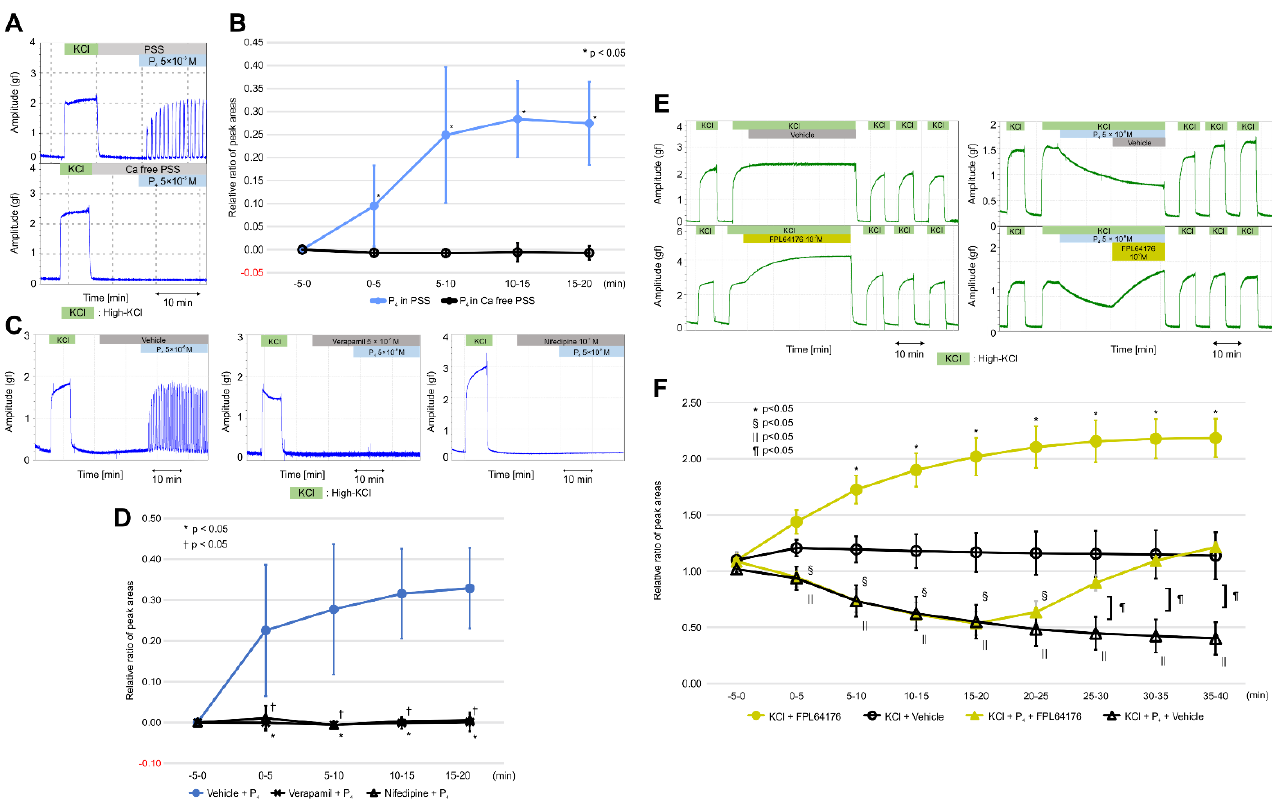
Figure 4. Effects of calcium-free physiological saline solution (PSS), verapamil, and nifedipine on progesterone-induced contractions in the resting myometrium, and the effect of FPL64176 on progesterone-induced inhibition against high- KCl-induced contractions. ( A ) Representative myograph of six myographs obtained when progesterone (5 × 10 − 6 M) was added into calcium-free PSS and PSS. ( B ) Time-dependent changes in the relative ratio of the peak area (RRPA) of progesterone-induced contractions in calcium-free PSS and PSS. ( C ) Effects of verapamil and nifedipine on progesterone-induced contractions, as shown by the representative myograph of six myographs obtained from experiments in which myometrial strips were pretreated for 15 min with verapamil (5 × 10 − 7 M) or nifedipine (10 − 7 M), progesterone (5 × 10 − 6 M) was added, and the strips were cotreated for 20 min with verapamil or nifedipine. ( D ) Time-dependent changes in the RRPA of progesterone-induced contractions in the verapamil- and nifedipine-pretreated groups. ( E ) Representative myograph upon progesterone (5 × 10 − 6 M), FPL6417 (10 − 7 M), or the vehicle addition in high-KCl-induced contractions. Progesterone was added 5 min after the tonic contraction was induced by high KCl. FPL64176 or the vehicle was added 20 min after the addition of progesterone. ( F ) Time-dependent changes in the RRPA of high-KCl-induced contractions in the FPL64176 alone, vehicle alone, progesterone-FPL64176, and progesterone-vehicle groups.